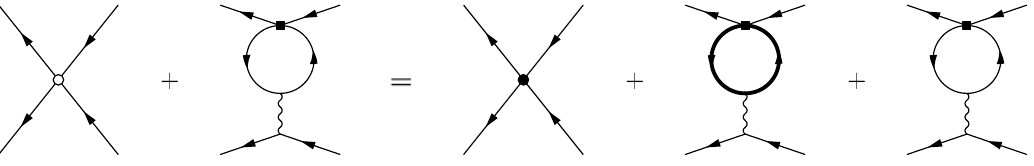
Figure 4 . Matching condition at the m b ( m c ) scale for the operator ((cid:22) e iL (cid:13) (cid:22) e jL ) ((cid:22) e kL (cid:13) (cid:22) e nL ). On the right the amplitude is computed above the mass threshold. The thick line represents a bottom (charm) loop. On the left the amplitude is evaluated below the mass threshold. The tree-level diagram with an open circle is the unknown. The loop diagrams with thin lines cancel among each